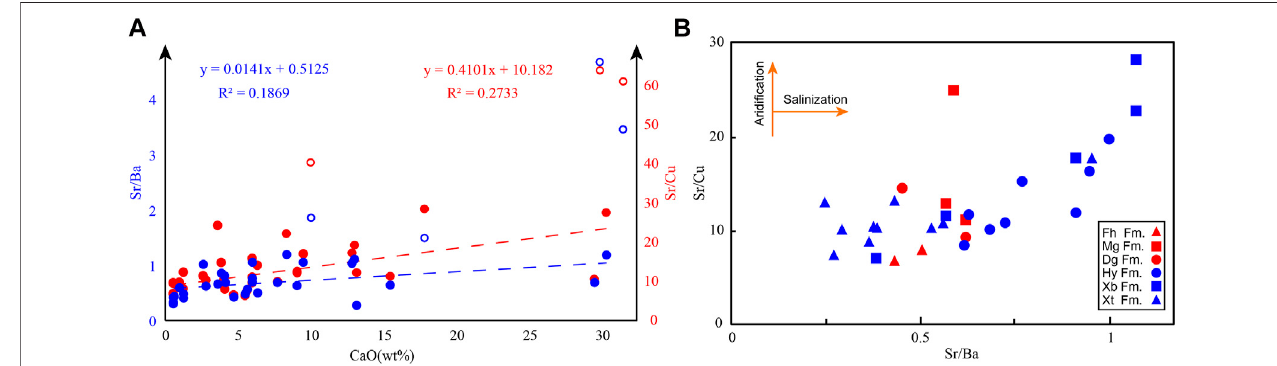
FIGURE5|(A) CorrelationbetweenSr/Ba(blue)andSr/Cu(red)indexesandCaOcontent.Theopencirclesrepresentabnormaldata,whicharein fl uencedbyCaO dramatically. (B) Sr/Cu and Sr/Ba binary diagram for the ZK01 core (after Lerman 1989) without the discarded data in (A) , indicating aridi fi cation and salinization conditions,